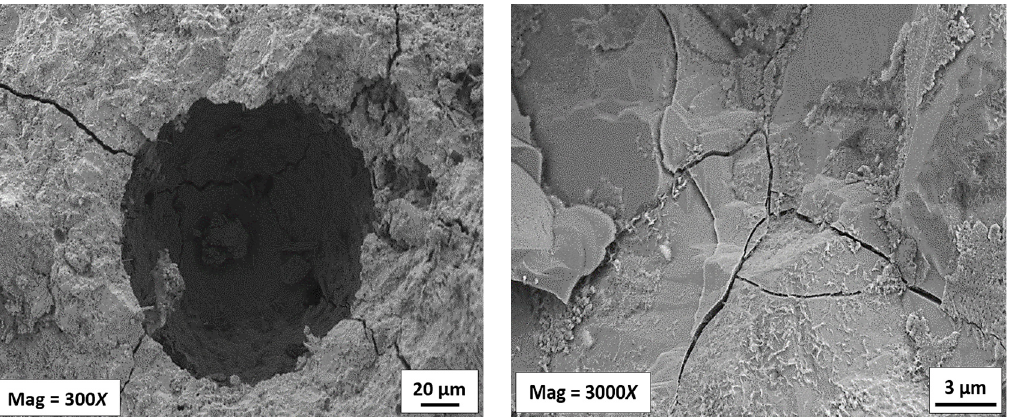
Figure 10. Expansion results for specimens exposed to ASR conditions: ( a ) specimens incorporating CA; ( b ) ASTM limits.